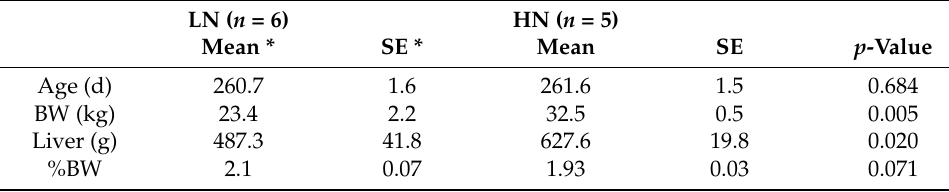
Table 1. Phenotypic effect of maternal nutrient restriction on fetal